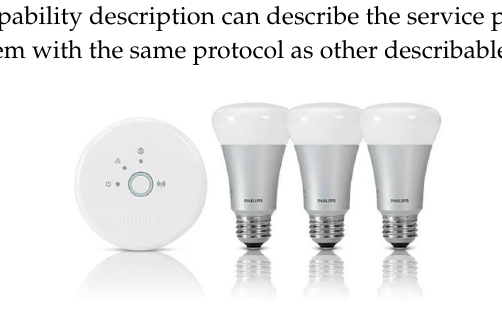
Figure 8. The Philips Hue.